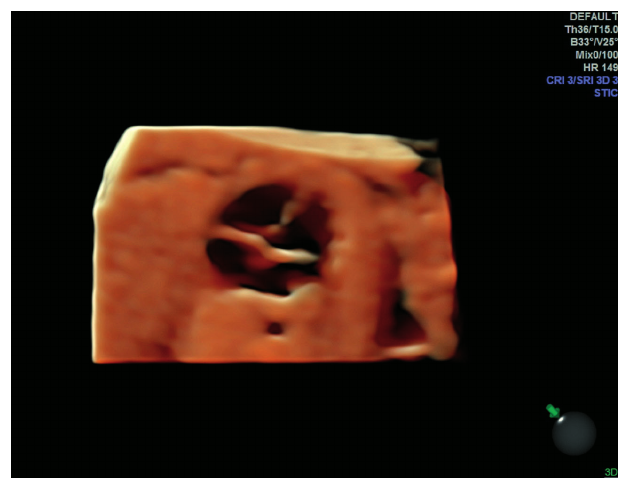
Fig. 1 - STIC-HDlive rendering showing the reconstruction of fetal heart in the four-chamber view